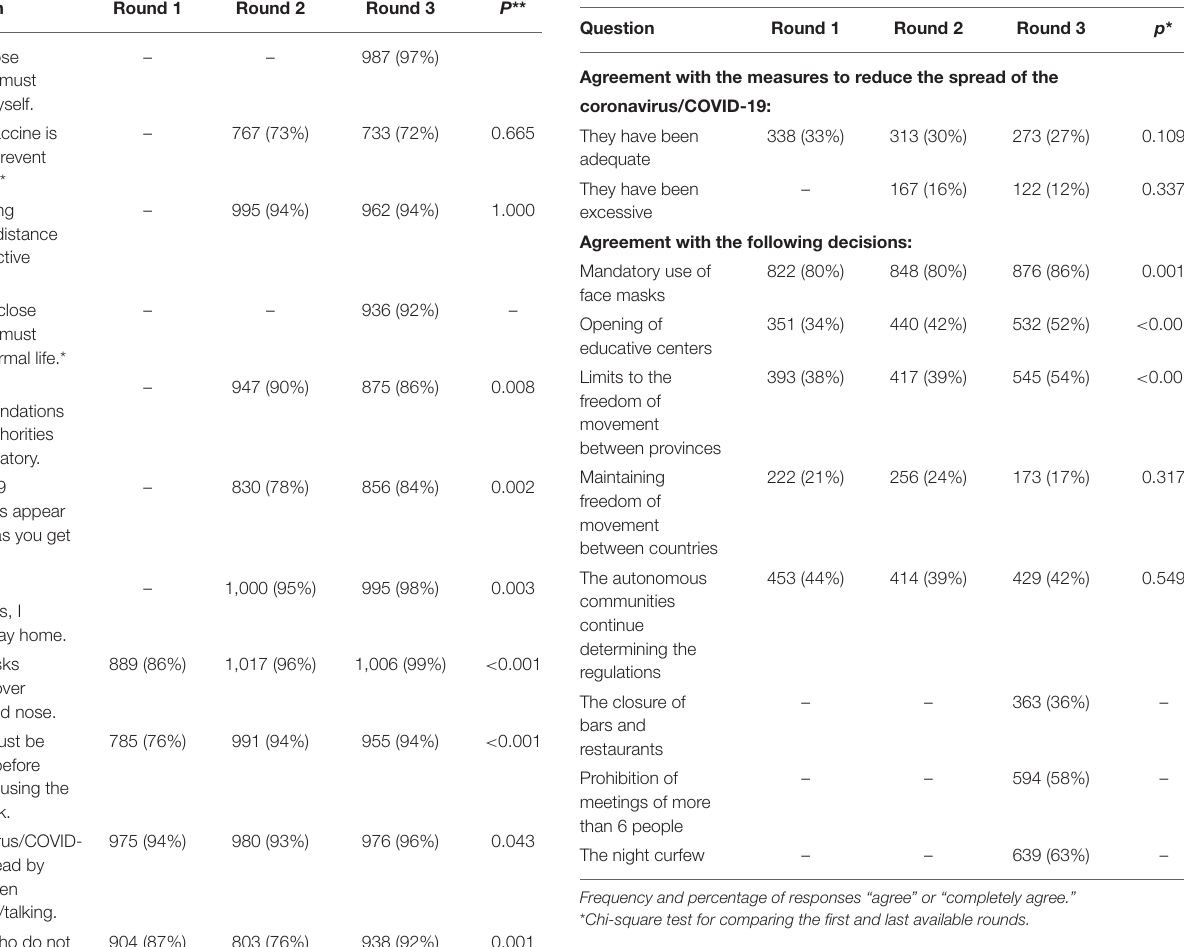
TABLE 3 | Attitudes toward preventive measures and political decisions in each